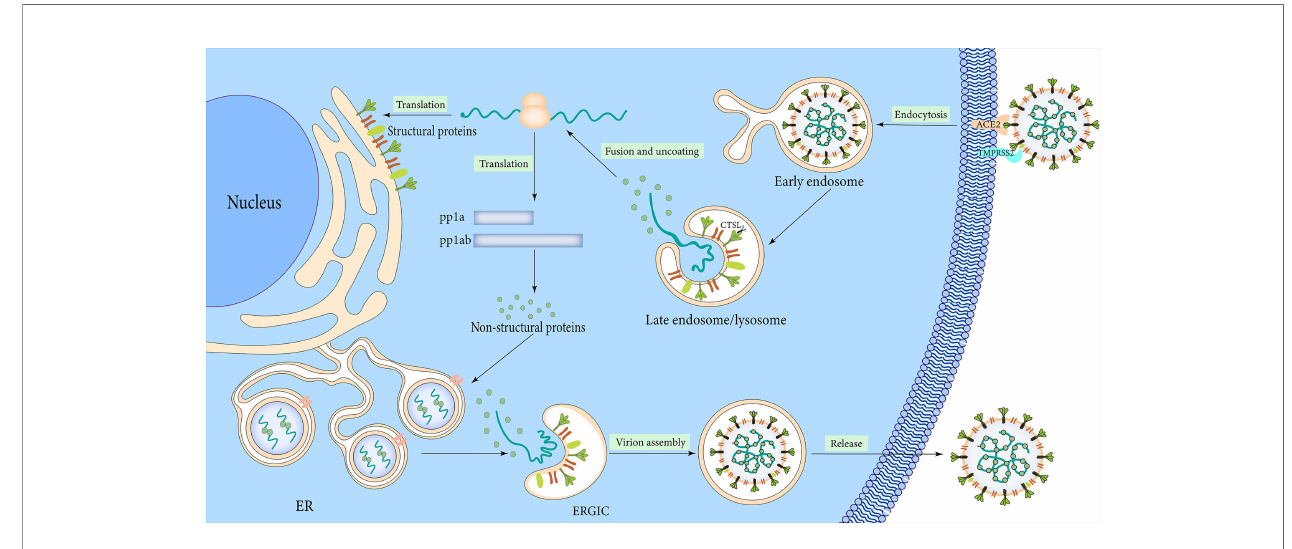
FIGURE 3 | Infection mechanism of